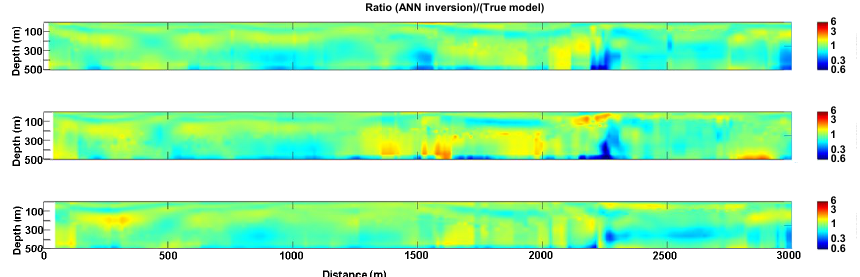
Figure 4. The ratio between the conductivity models in Figure 3 (the ANN result) and in Figure 2 (the true conductivity